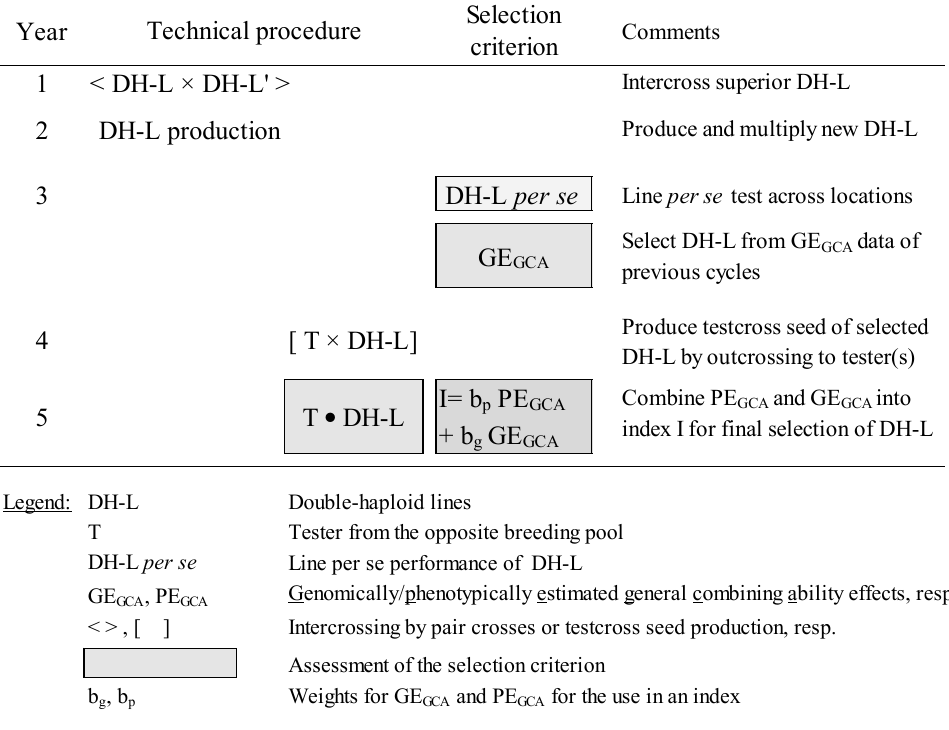
Figure 4. Breeding scheme for combined genomic and phenotypic selection in hybrid breeding (Peer Wilde, pers. commun.).